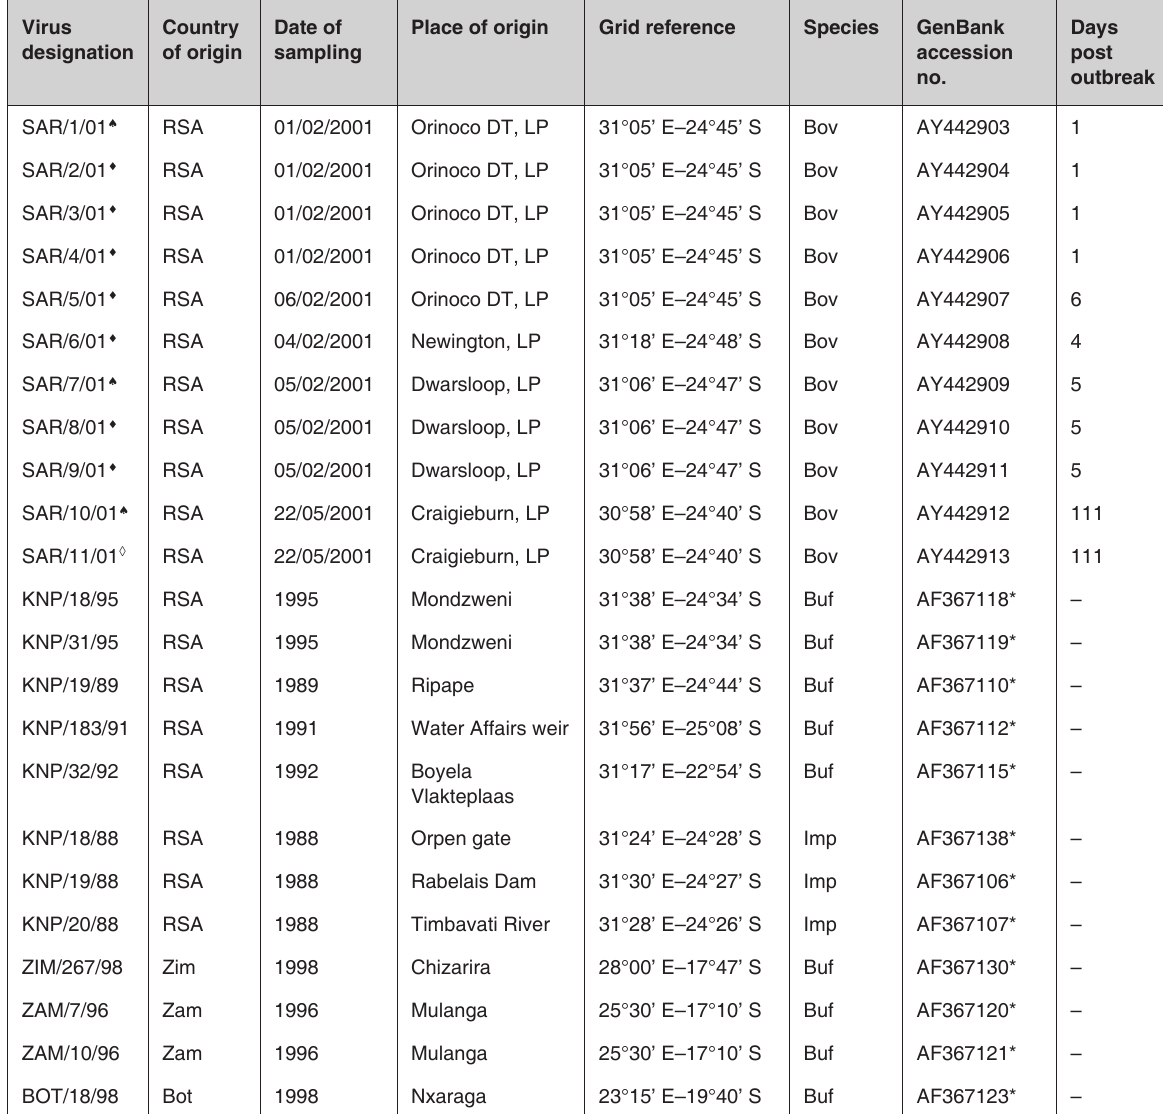
TABLE 1 Summary of SAT-2 serotype isolates included in this study Virus Country designation of